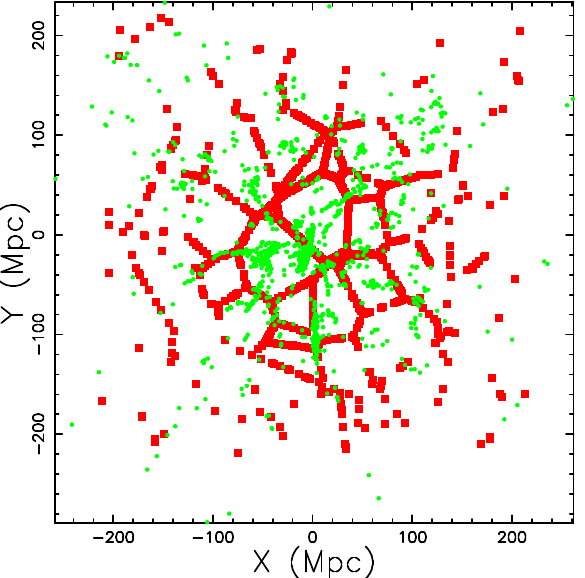
Figure 8. Histogram (step-diagram) of the number of clusters in redMaPPer as a function of the redshift.